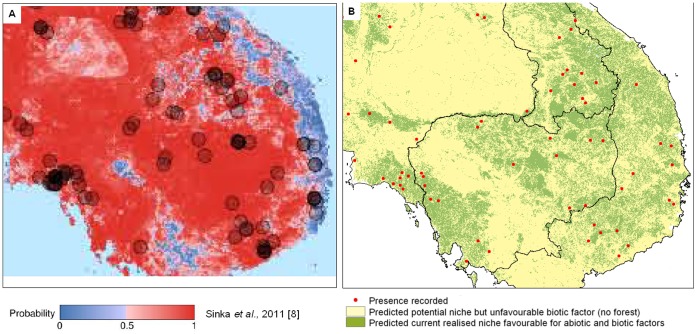
Comparison between Anopheles dirus sensu lato predicted distribution maps.Illustration of differences between the A) predicted distribution developed using Boosted Regression Tree presented by the Malaria Atlas Project [8] and B) the current distribution map developed in this paper.